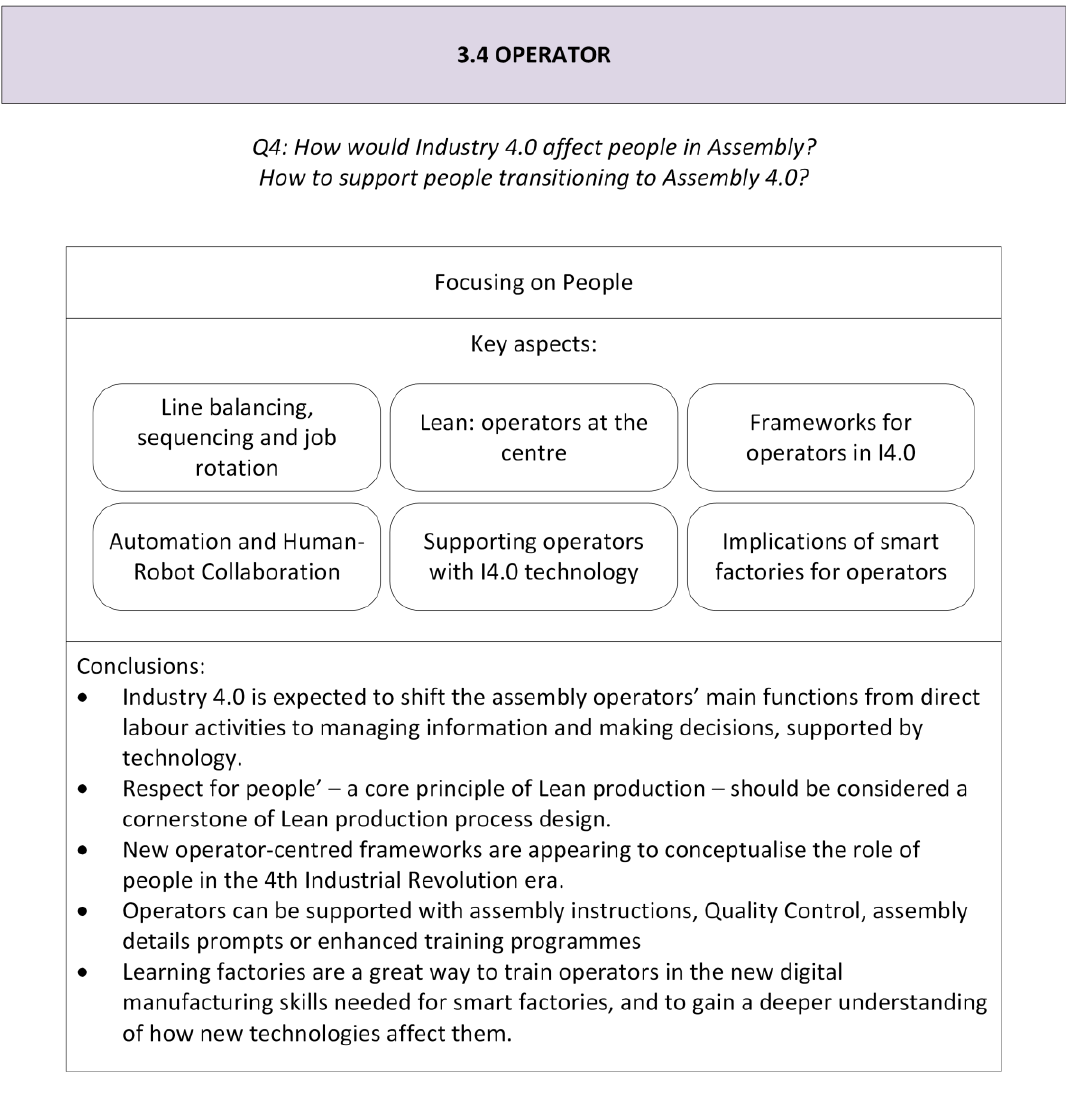
Figure 8. Key aspects of operators in Industry 4.0, and main conclusions of the analysis.